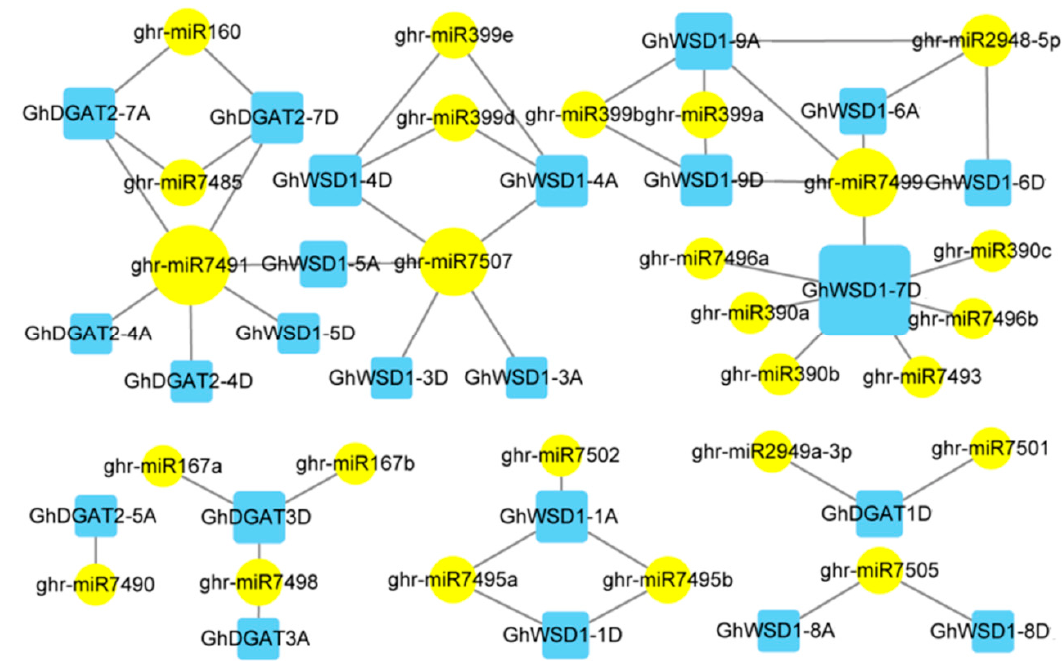
Figure 6. miRNA targets GhDGAT and GhWSD1 genes. The predicted regulation miRNAs are marked with a round yellow background, the target GhDGAT and GhWSD1 genes are marked with blue rectangles. The regulation and targeting levels are shown with varying degrees.